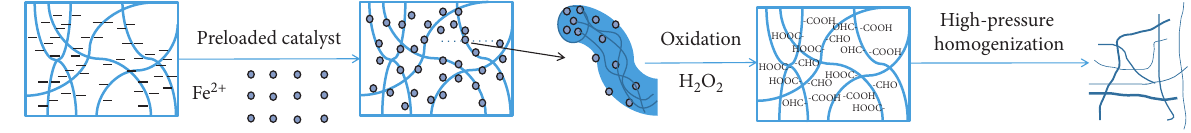
Figure 9: The principle of catalyst-preloading Fenton oxidation technology based on a microreactor for MFC